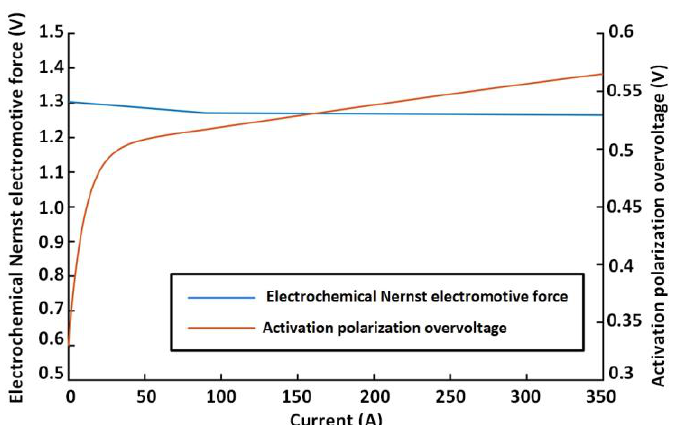
Figure 7. Electrochemical Nernst electromotive force and activation polarization overvoltage change with current.